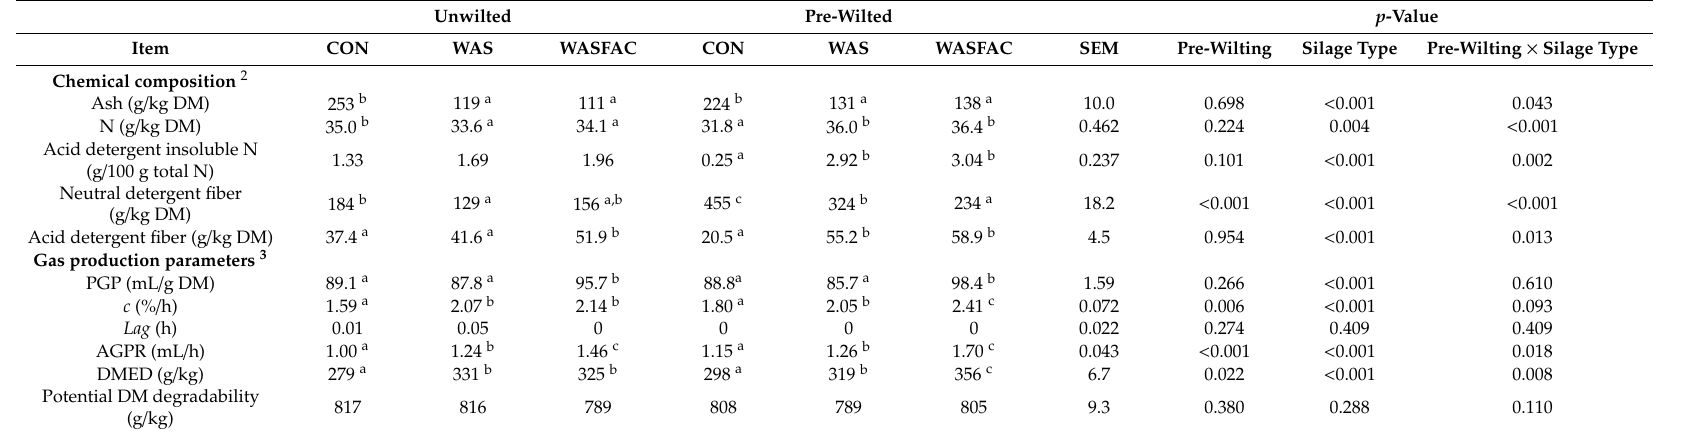
Table 4. Chemical composition and gas production parameters of Porphyra umbilicalis silages 1 . Unwilted Pre-Wilted p -Value Pre-Wilting Silage Type Pre-Wilting × Silage